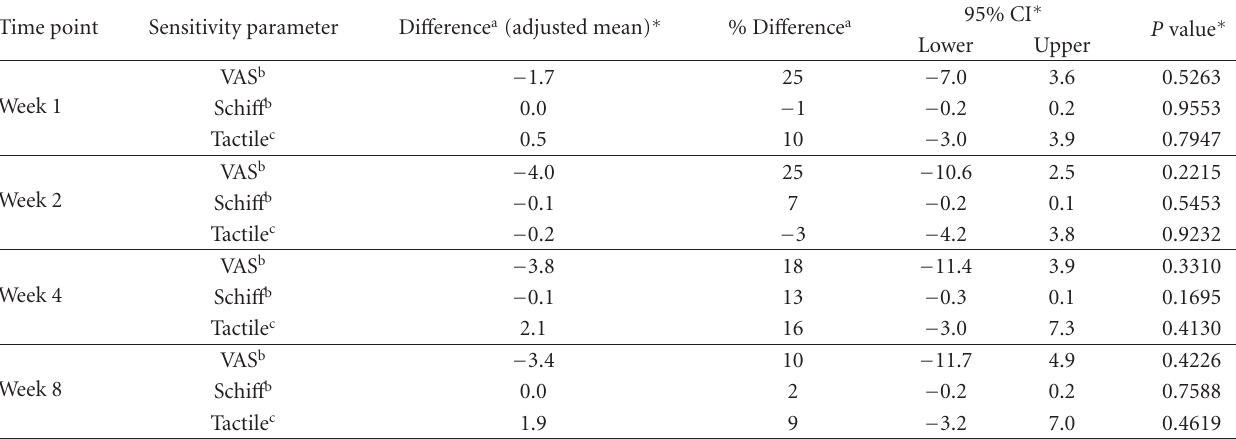
Table 2: Treatment group comparisons (ITT population) for Dentifrice A (Sensodyne Multi Action Iso-Active) versus Dentifrice B (Colgate Sensitive Pro-Relief). ∗ From ANCOVA model with the following factors: treatment, baseline VAS stratification value (for Schi ff and Tactile analyses), number of air sensitive teeth (covariate), and baseline (covariate). a Calculated as (adjusted mean di ff erence/adjusted mean for